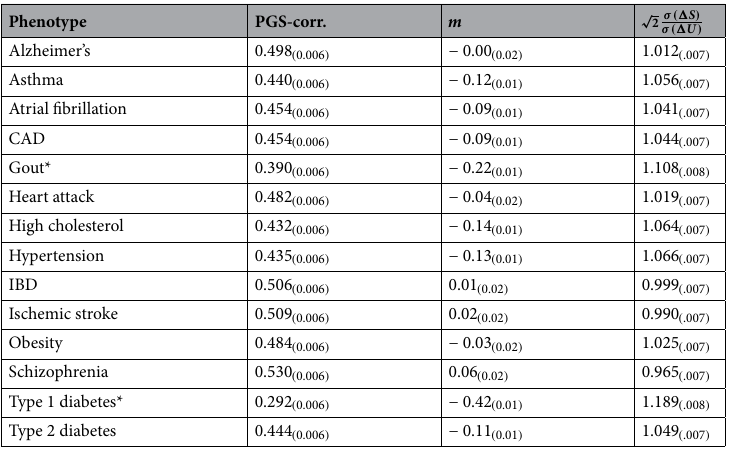
Table 2. Descriptive statistics for disease condition PGS: the ratio of unrelated ( U ) vs sibling ( S ) standard deviations is seen be √ 2 for essentially all disease PGS. σ(� U ) is the standard deviation of the PGS-difference among unrelated individuals and σ(� S ) is the corresponding standard deviation among siblings. PGS-corr. refers to correlation in polygenic score between siblings, and m is the implied assortativity. The analysis was performed on N = 21, 709 pairs of siblings/unrelated individuals. All uncertainties, listed in parentheses, are standard errors. *Note the population distributions for Gout and T1D deviate substantially from Gaussian (both have very sparse genetic architecture), so the derived values in the table should be interpreted with